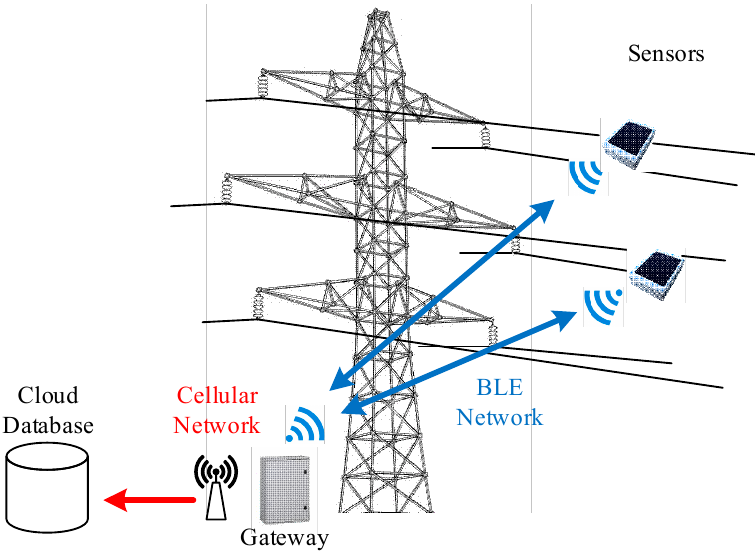
Figure 7. Architecture of the developed monitoring